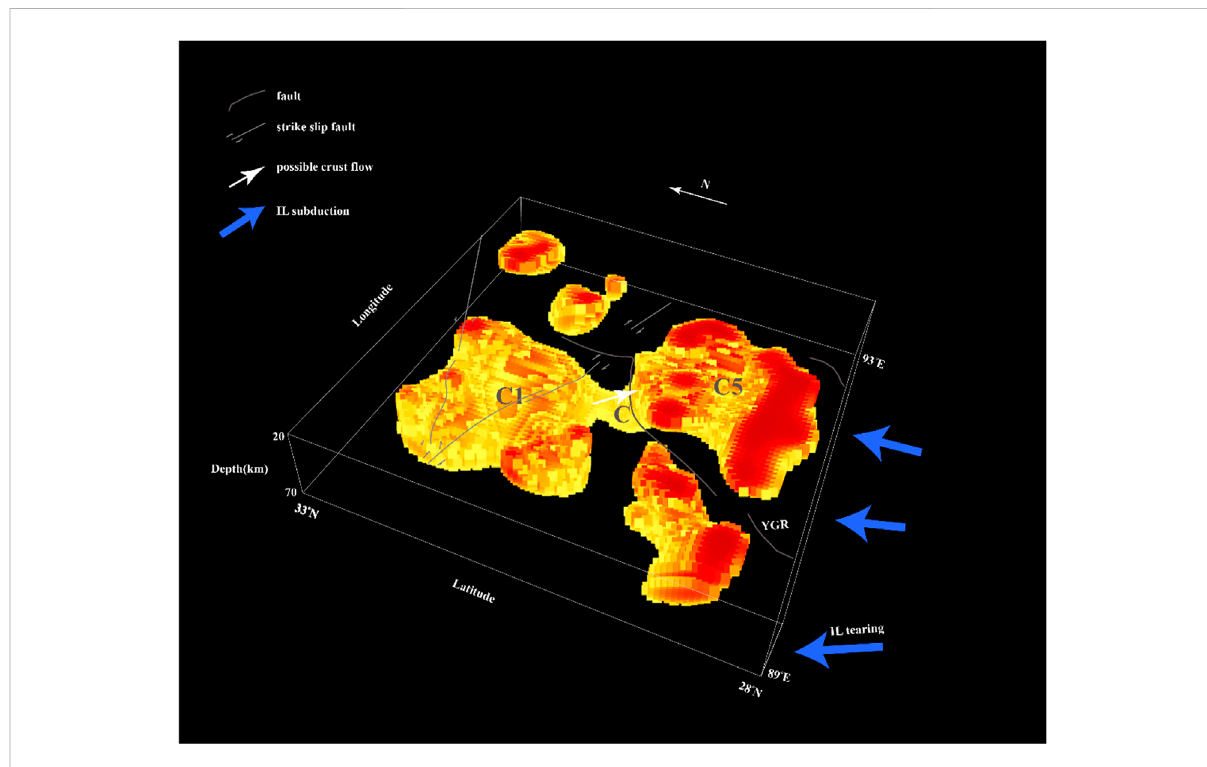
FIGURE 15 3-Dviewofthecrustelectricalstructureofthestudyarea.Themaximumresistivityofthismodelis26.5 Ω · m betweendepthsof20and70 km. Tectonic processes are marked schematically. IL, Indian Lithosphere; YGR, Yadong-Gulu